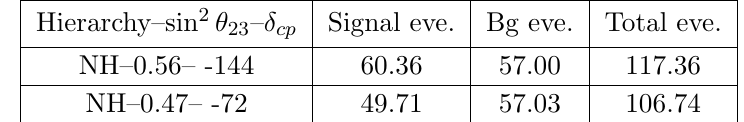
Table 7 . Number of expected (cid:23) e appearance events for one year (cid:23) run of DUNE, for the two solutions in refs. [39, 40].